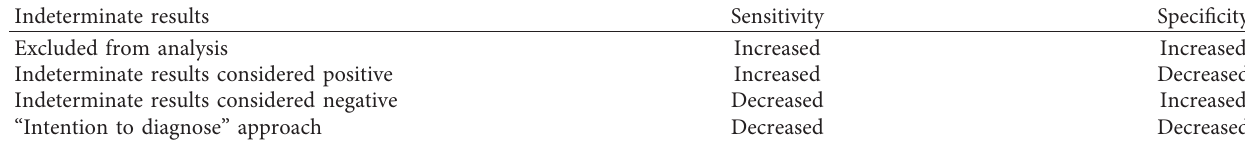
Table 2: Various approaches for indeterminate index test results and their effect on sensitivity and